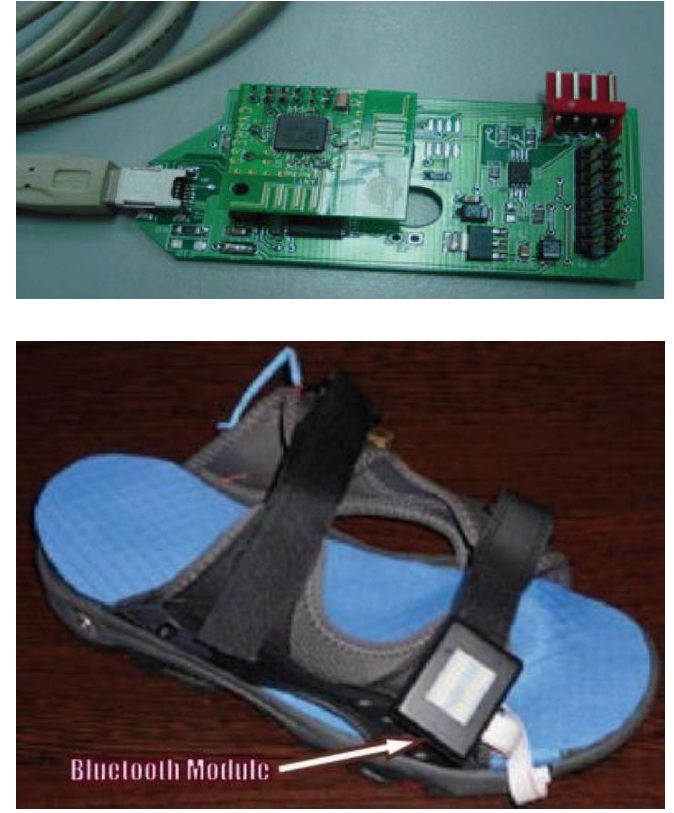
Figure 26. Neaga et al. [8] microcontroller board and shoe prototype.